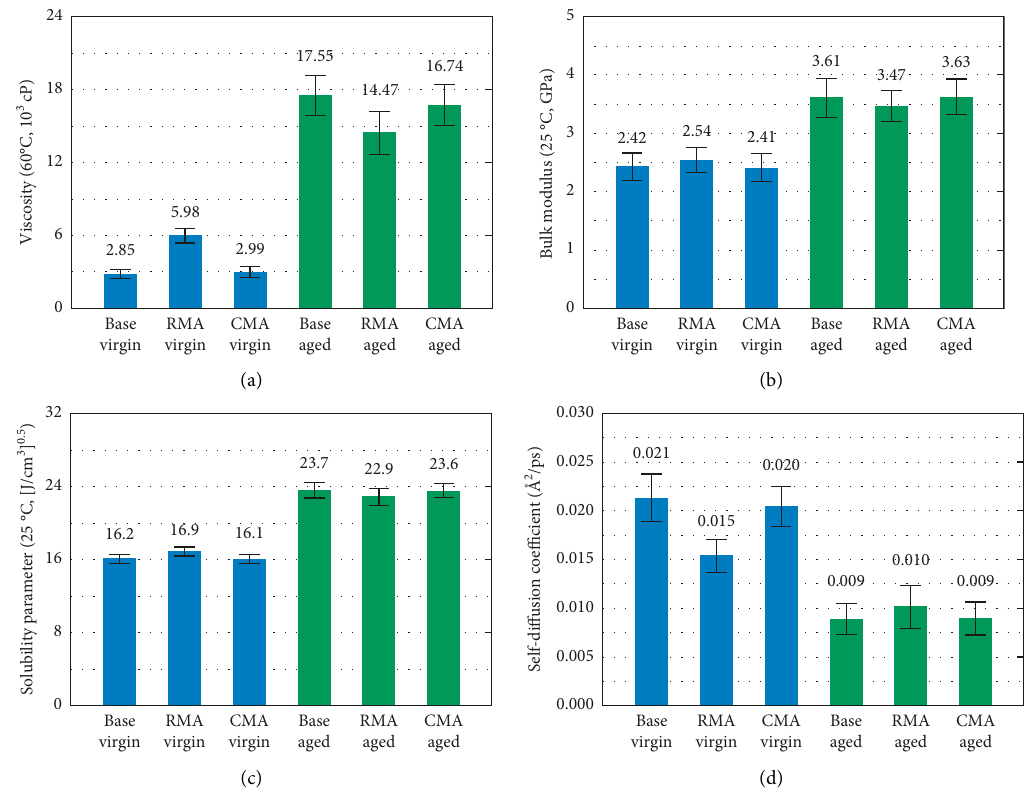
Figure 10: Effects of modifiers on the hardening-related parameters of aged asphalt: (a) viscosity; (b) bulk modulus; (c) solubility parameter; (d) self-diffusion